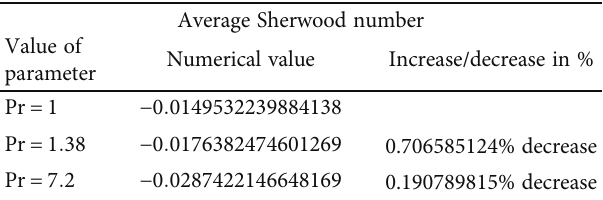
Table 9: Variability of the curve when Y = 0 : 5 in Figure 8(h).